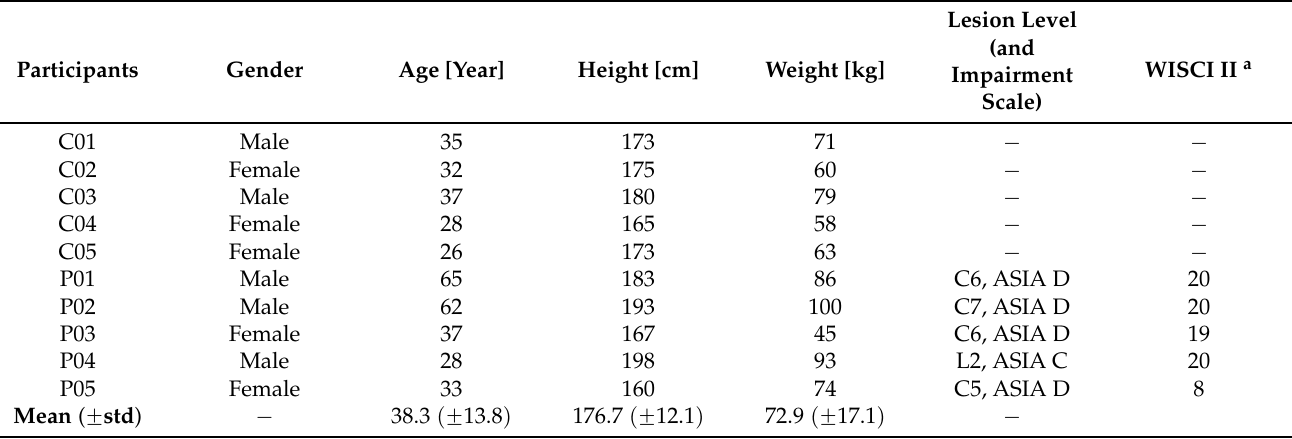
Table 1. Participants’ anthropomorphic